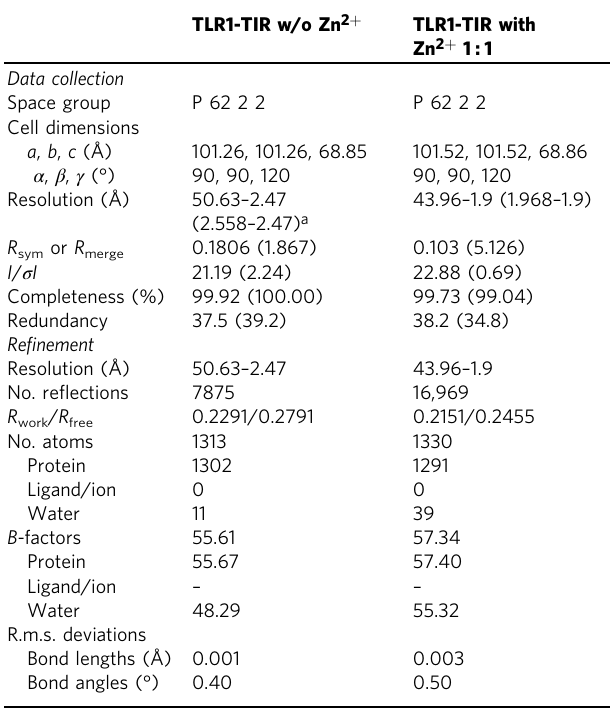
Table 1 NMR and re fi nement statistics for protein structures.